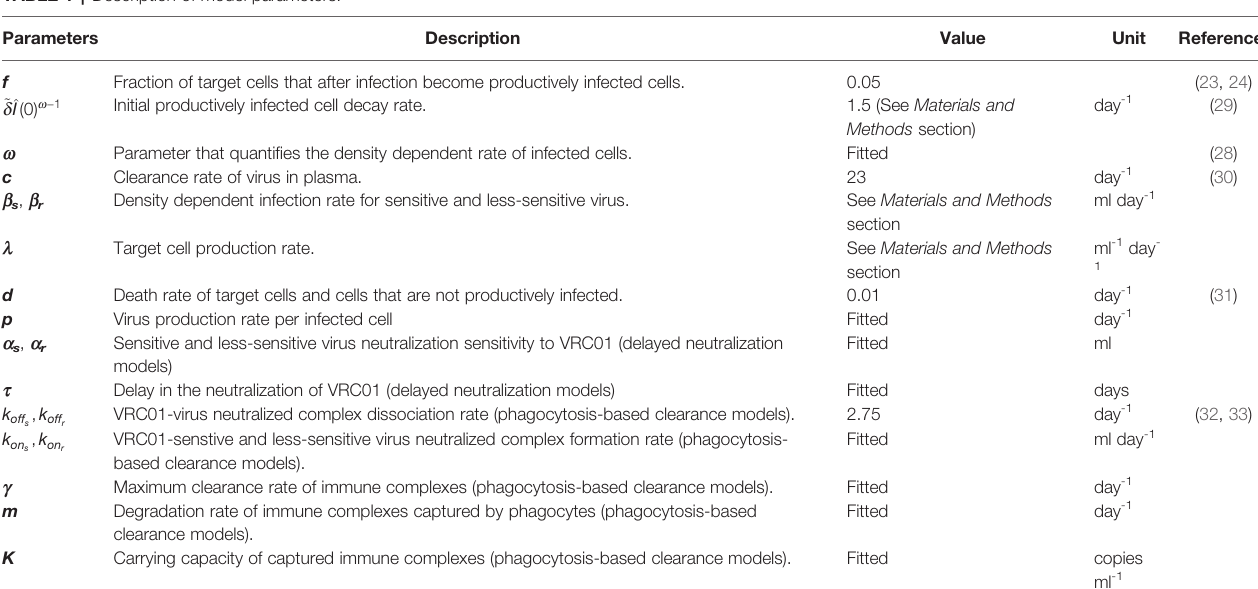
TABLE 1 | Description of model parameters.